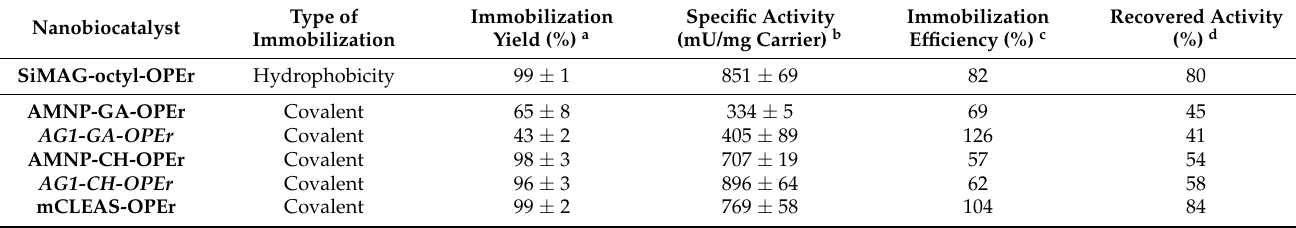
Table 1. Summary of the immobilization parameters of the biocatalysts with OPEr used in this study.